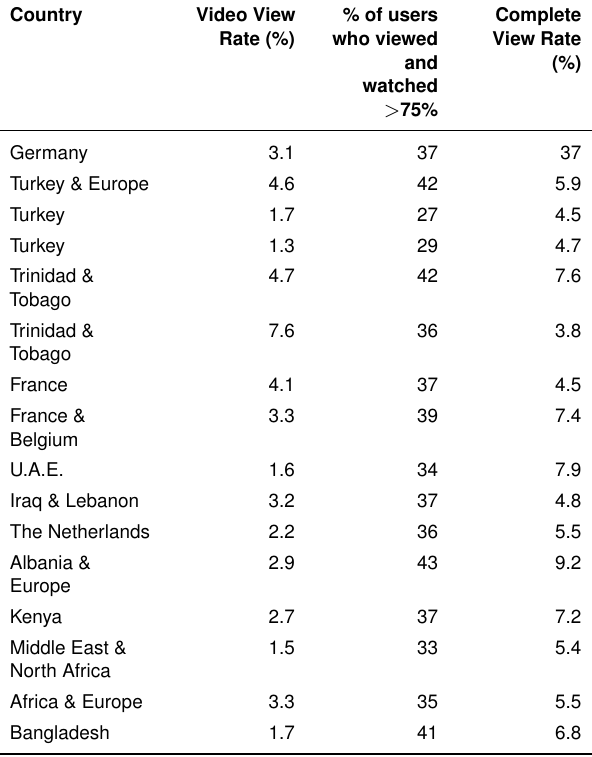
Table 5. Video engagement